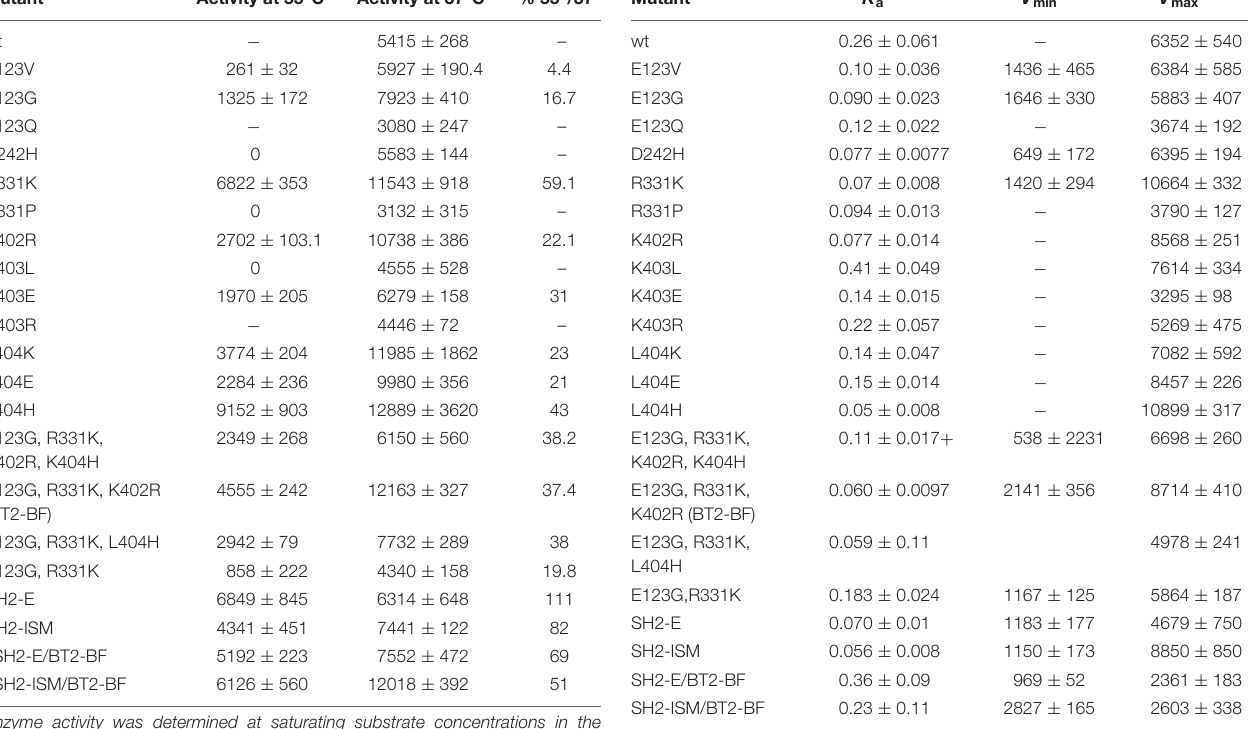
TABLE 2 | AGPase activity at 37 and 55 ◦ C in Bt2 variants with substituted amino acids. Mutant Activity at 55 ◦ C Activity at 37 ◦ C